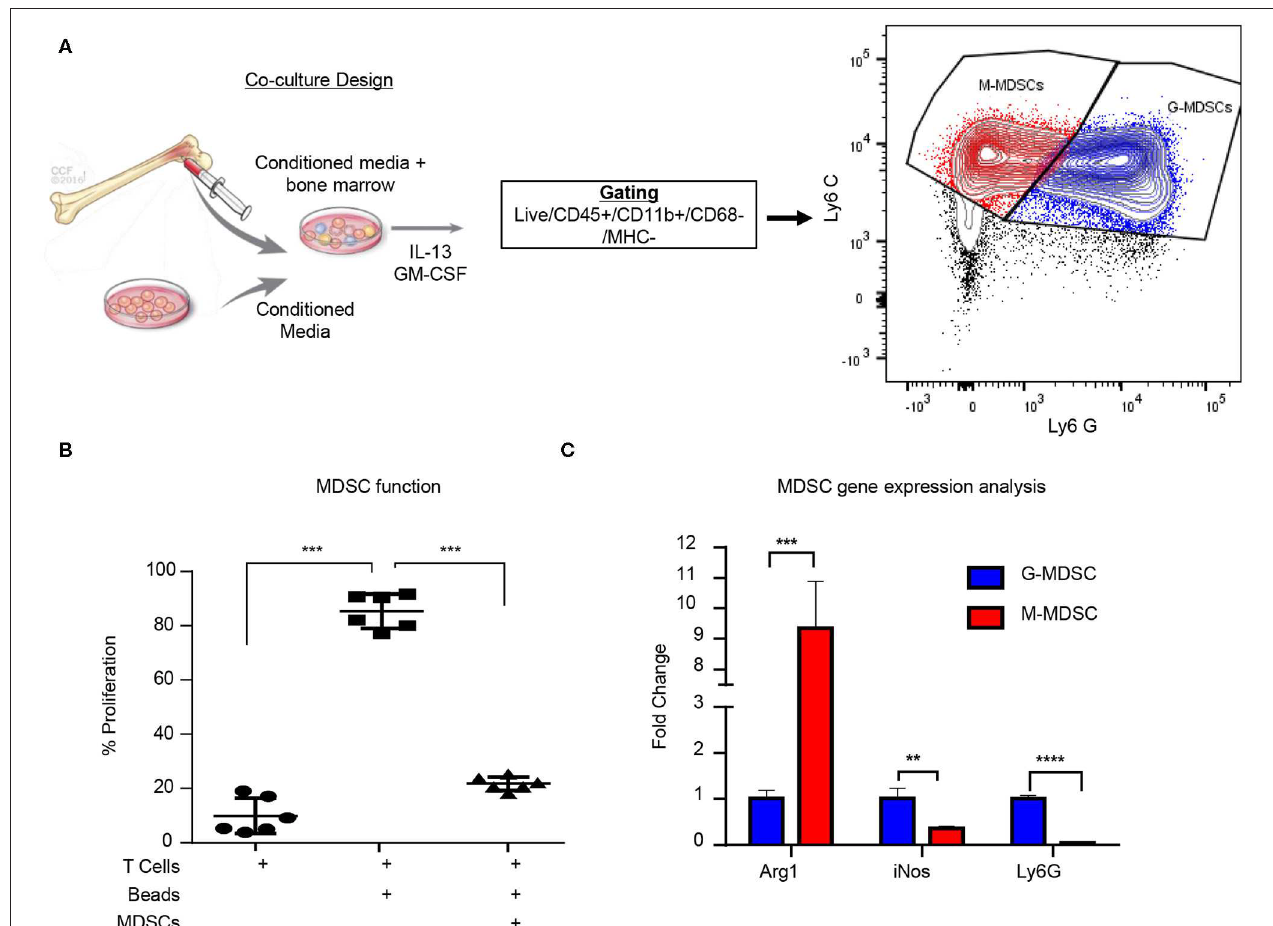
FIGURE 1 | Glioma educated MDSCS can be generated in vitro. MDSCs are induced using freshly isolated bone marrow cultured with 50:50 mix of fresh media and conditioned media from a 24-h culture of GL261 cells with the addition of IL-13 and GM-CSF over 3 days (A) . M-MDSCs were gated by Live/CD45 + / CD 11 b + / CD 68 − / MHC − / Ly 6 C + / Ly 6 G − while G-MDSCs were gated by Live/CD45 + / CD 11 b + / CD 68 − / MHC − / Ly 6 C + / Ly 6 G + . Co-cultured MDSCs from n = 6 mice were generated over 3 days and then isolated by magnetic bead sorting and subsequently used for T cell suppression assay where the controls were T cells alone unstimulated without CD3/CD28 activation beads and T cells with CD3/CD28 activation beads (B) . FACs sorting of M-MDSCs and G-MDSCs from 3 day old co-cultures of n = 3 mice was used to isolate RNA and perform qPCR for Arginase (Arg1), Nitric oxide synthase (iNOS), and Ly6G (C) . Two-Tailed T -Test was performed for comparisons in (B,C) *<0.05, **<0.01,